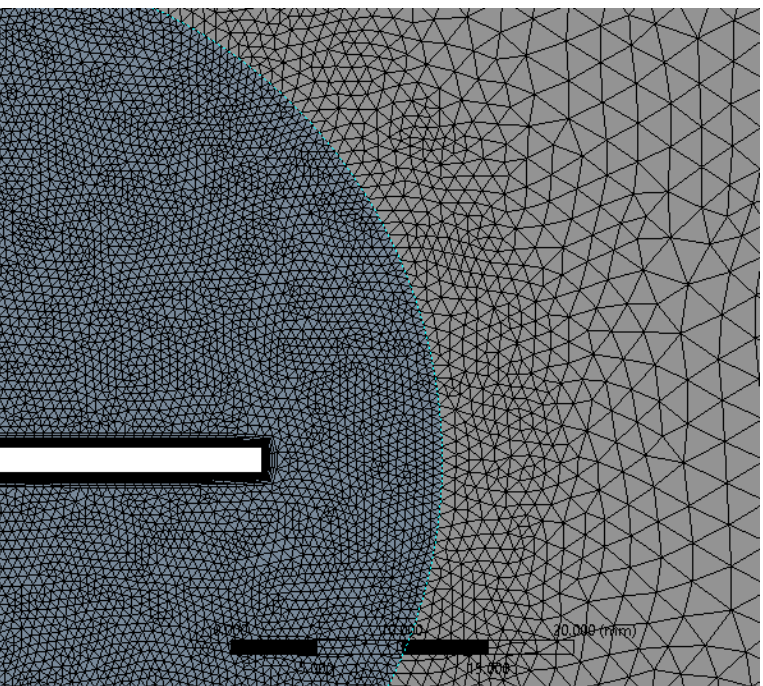
Figure 12. Local refinement within the dynamic and static fluid zones for uniform residual convergence.